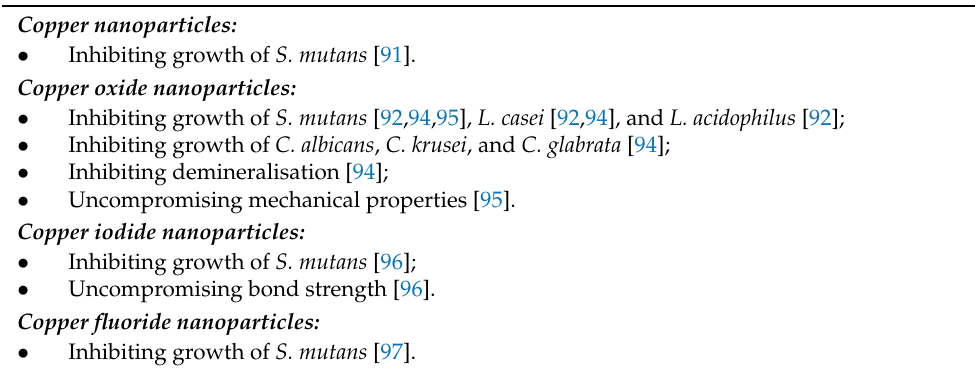
Table 5. Properties of copper nanoparticle and their related products in caries